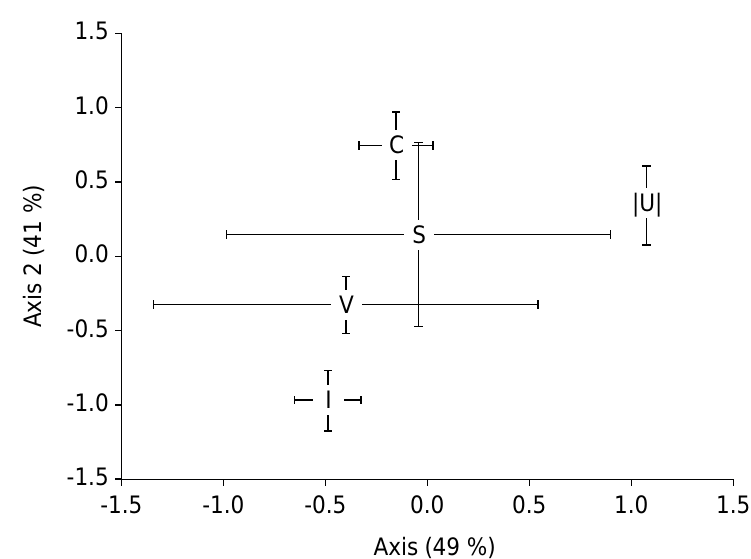
Figure 3. Ordination obtained by the non-metric multidimensional scaling, representing the similarity between forest areas, according to the variation in 13 C aggregate size classes properties (C content aggregate size classes; C distribution by aggregate size classes; and sum of organic C of aggregates size classes), 0.00-0.08 m soil layer. Standard deviation for each group (n = 3) along the axes 1 and 2 is scaled by the bars. C = Coruripe; U = Umbaúba; V = Nova Viçosa; S = Sooretama; I = Itaboraí.